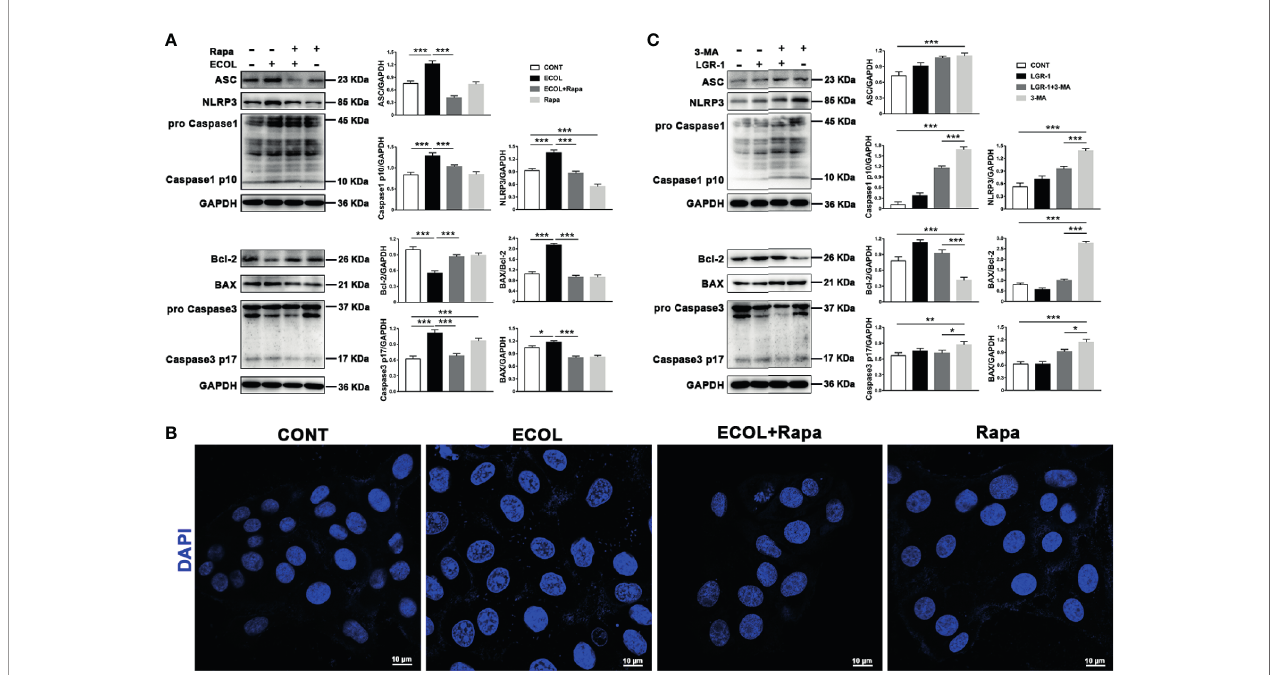
FIGURE 4 | LGR-1 alleviates Escherichia coli- induced inhibition of mitophagy to suppress NLRP3 in fl ammasome activation and apoptosis in MAC-T cells. (A, C) Western blot analysis of ASC, NLRP3, Caspase-1, BAX, Bcl-2, and Caspase-3. The right panel shows the protein quanti fi cation by ImageJ software (version 1.50). (B) Cell apoptosis was detected by staining the nucleus with DAPI (Blue). Scale bar, 10 µm. MAC-T cells were pretreated with LGR-1 (MOI = 1) for 3 h and then treated with 3-methyladenine (3-MA, 5 mM) for 12 h or pretreated with rapamycin (Rapa, 2 m M) for 12 h and then treated with E coli (MOI = 66) for 8 (h)